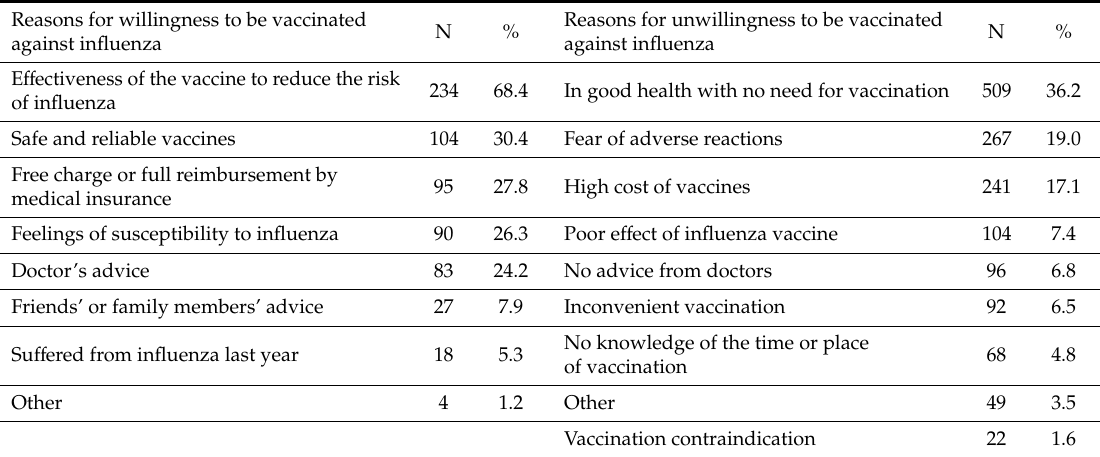
Table 2. Reasons for willingness and unwillingness among patients with T2DM to receive seasonal influenza vaccination (multiple